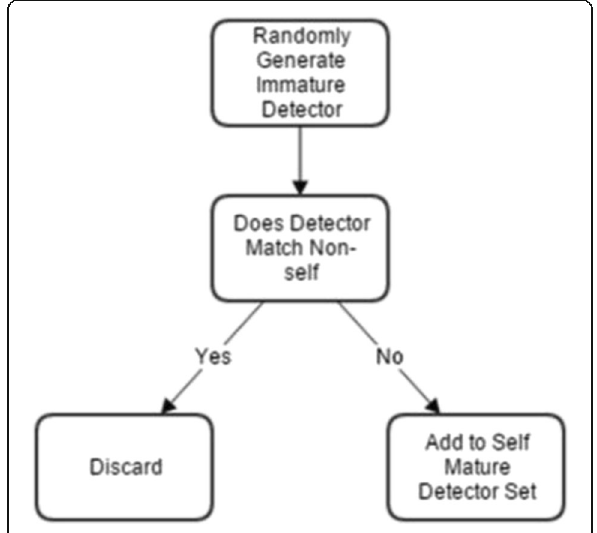
Fig. 2 Self detector set generation